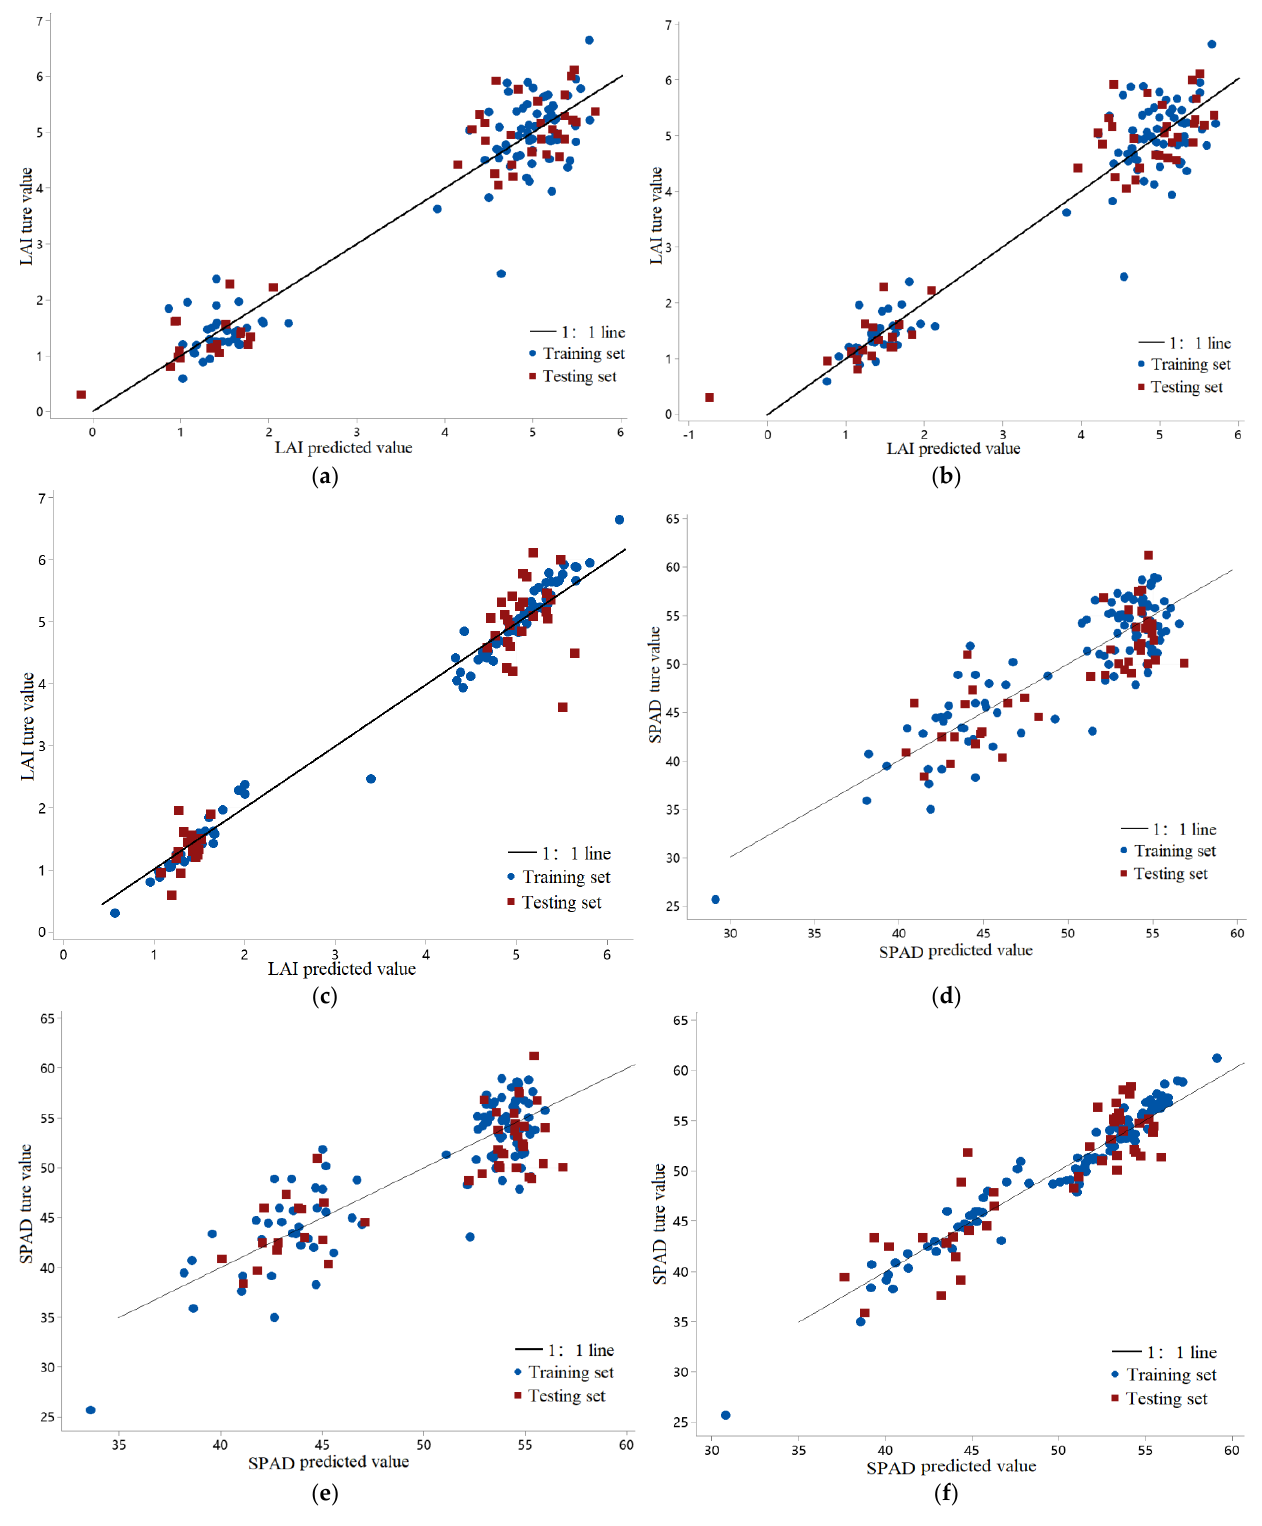
Figure 4. Inversion model of summer maize growth parameters based on multi-source data fusion. ( a ) MLR model inversion of LAI; ( b ) PLSR model inversion of LAI; ( c ) RF model inversion of LAI; ( d ) MLR model inversion of SPAthe; ( e ) PLSR model inversion of SPAD; ( f ) RF model inversion of SPAD.